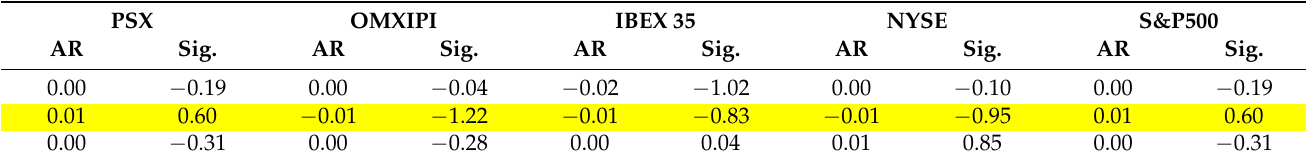
Table A7. Abnormal returns of the ( − 1, +1) event window (News of Panama leaks).